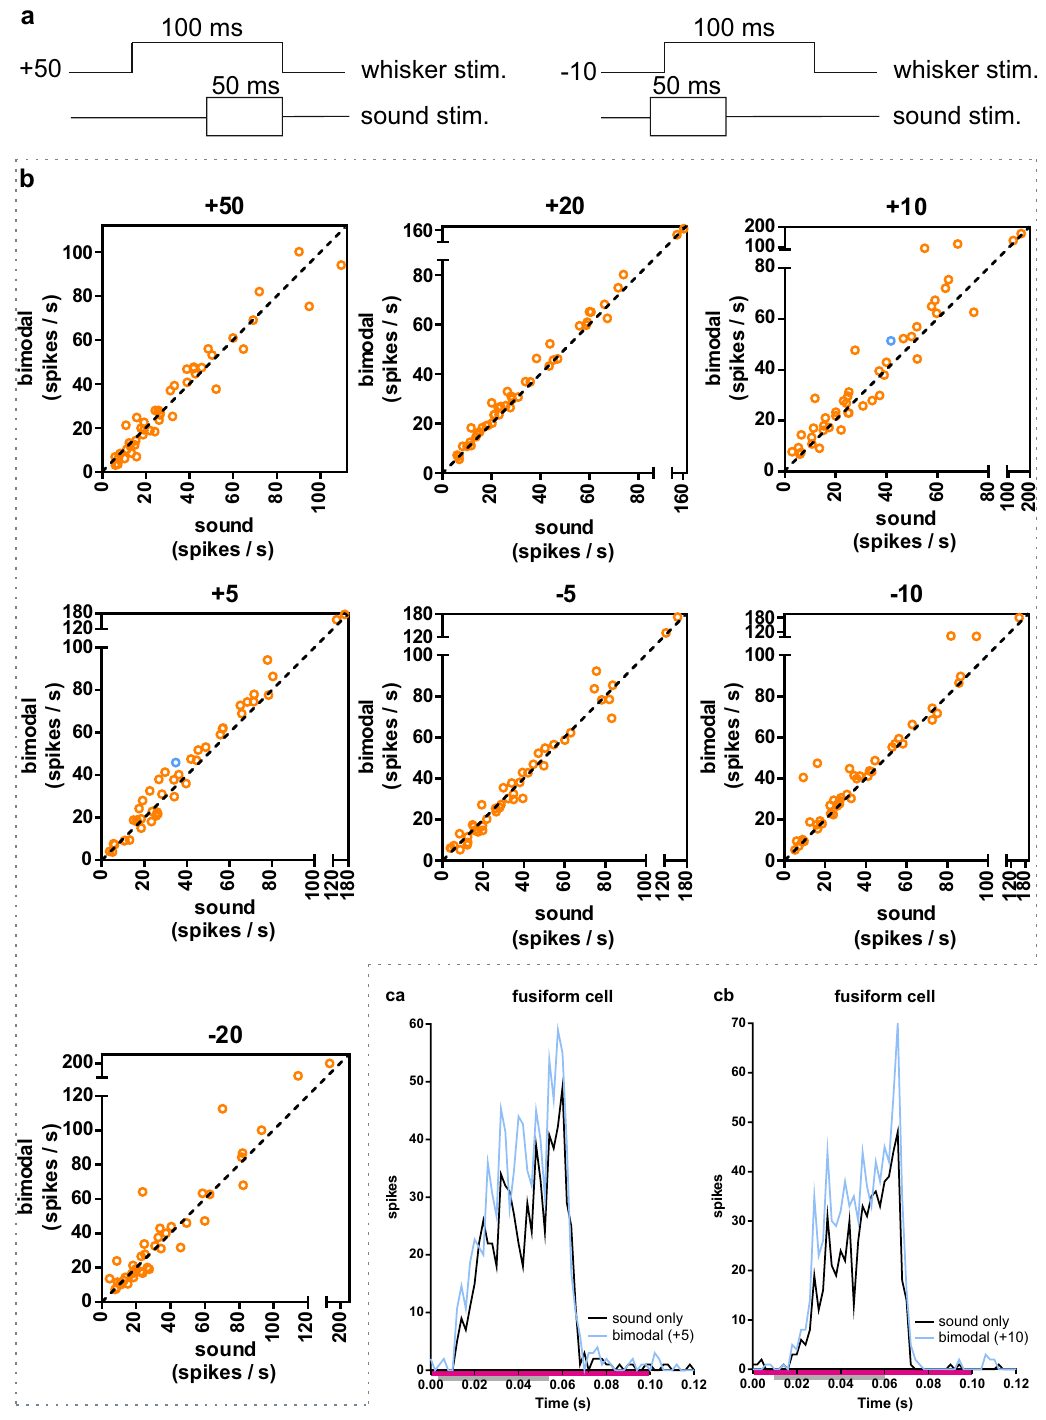
Figure 3. Bimodal responses in fusiform cells. ( a ) Two schematic examples of how the different stimulation protocols were performed. Left : A 100 ms whisker stimulation starting 50 ms before (“ + 50”) the onset of a 50 ms sound (broadband noise) stimulation. Right : A 100 ms whisker stimulation starting 10 ms after (“−10”) the onset of a 50 ms sound stimulation. ( b ) Bimodal (whisker and sound) response compared to only sound stimulation. Each protocol (+ 50, + 20 + etc.; see Methods) is plotted separately and each spike-sorted unit is represented with a circle. The dotted line represents a linear regression line with slope 1 (y = x). The bimodal + 20, + 10, + 5 and − 5 protocols evoked a larger response compared to only sound stimulation. See Table 1 for numbers and statistics. Blue circles (one in the + 5 and one in the +10 plot) are for the example cells in ca-cb . ( ca ) Example PSTH for a fusiform cell showing the response to only sound compared to the + 5 bimodal protocol. The bimodal response is increased compared to the only sound response. Pink bar shows the time of whisker stimulation (from 0 to 0.1 s); the grey bar marks the duration of the sound stimulation (from 0.005 to 0.055 s; sum of 500 stimulations each for sound and bimodal). ( cb ) Example PSTH for a fusiform cell showing the response to only sound compared to the + 10 bimodal protocol. The bimodal response is increased compared to the only sound response. Pink bar shows the time of whisker stimulation (from 0 to 0.1 s); the grey bar marks the duration of the sound stimulation (from 0.01 to 0.06 s; sum of 500 stimulations each for sound and